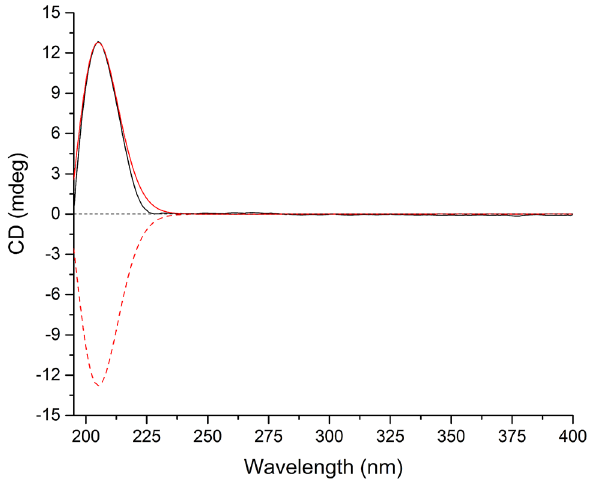
Fig. 5 Experimental ECD spectrum of 3 (black); Calculated ECD spectra of (6 R ,8 S )- 3 (shift = 12 nm, red) and (6 S ,8 R )- 3 (shift = 12 nm, red